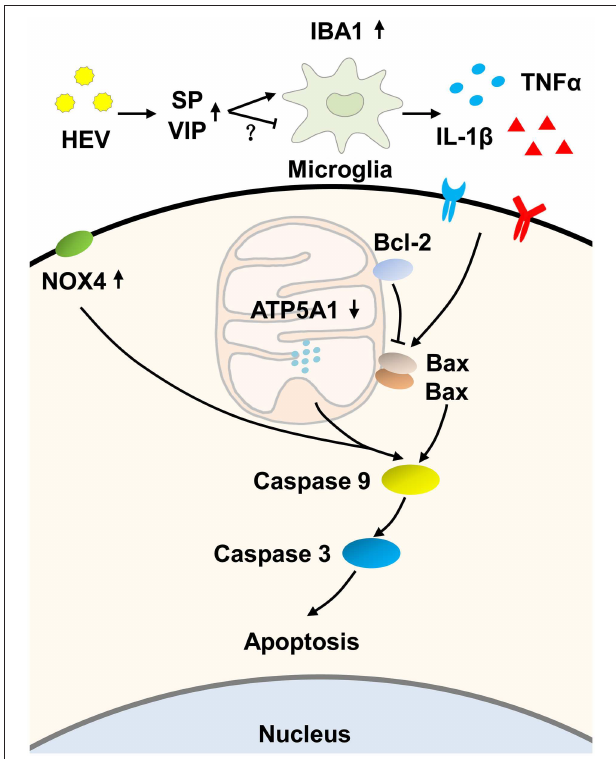
FIGURE 7 | Hypothesized pathway of mitochondrial apoptosis activation induced by HEV infection. HEV entry to the brain tissue promoted the release of Substance P (SP) to activate microglial cells, while increased production of vasoactive intestinal peptide (VIP) negatively regulated activation of microglial cells as a compensatory response. Activated microglial cells produced more inflammatory cytokines such as TNF α and IL-1 β . The release of TNF α and IL-1 β further initiated mitochondrial apoptotic pathway. During the process, pro-apoptotic protein Bax induced ruptures of the outer membranes altered mitochondrial membrane permeability and further induced activation of caspase-9. Up-regulated expression of NOX4 and down-regulated expression of ATP5A1 also contributed to activation of caspase-9 and caspase-3 cascade and ultimately induced mitochondria-mediated apoptosis, which might be a potential way to eliminate virus but on the other hand caused neurological